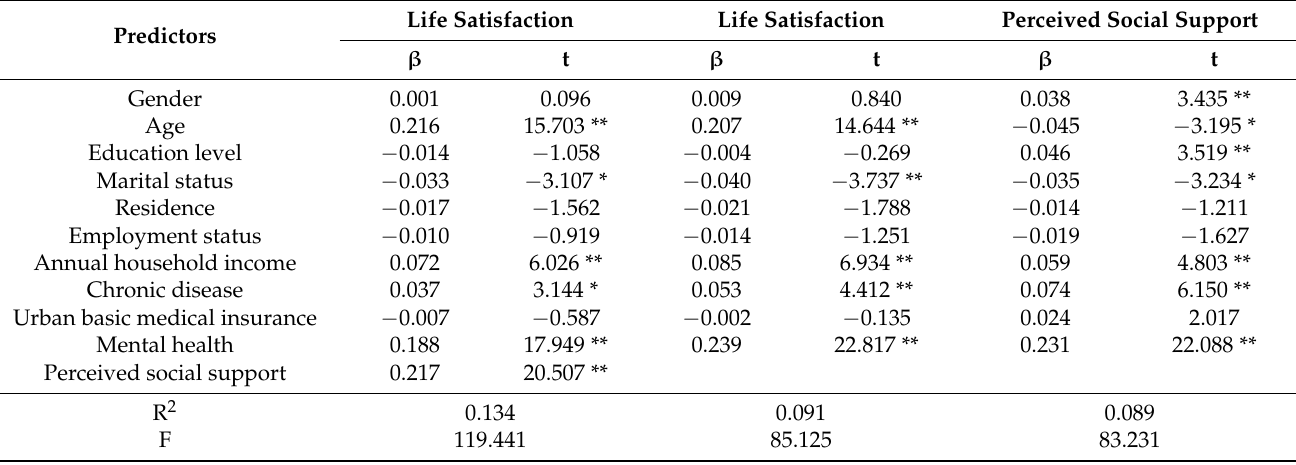
Table 3. The mediating effect of perceived social support on mental health and life satisfaction among the participants in Taian City, China, 2020 (N = 8500).